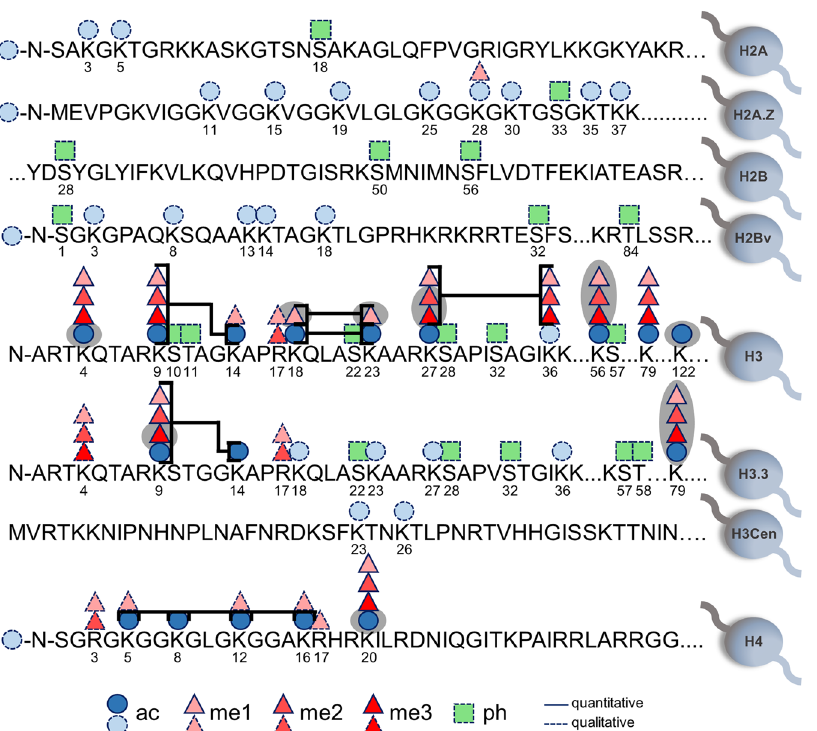
Figure 2. P. falciparum histone PTM landscape. A wide array of histone PTMs have been identified in P. falciparum , including 15 novel PTMs that were identified for the first time in this study (shaded grey). Five principles types of histone PTMs have previously been reported, including acetylation, methylation (mono-, di- and tri-), phosphorylation, ubiquitination and SUMOylation. In this study, 106 PTMs were identified (dashed line), but only 46 of these were quantifiable in all stages over life cycle development (solid line). Co-existing histone PTMs on individual peptides were also identified